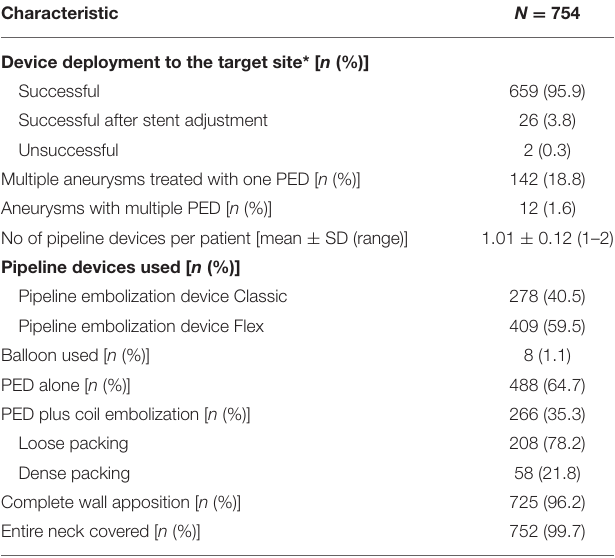
TABLE 3 | Procedural details.